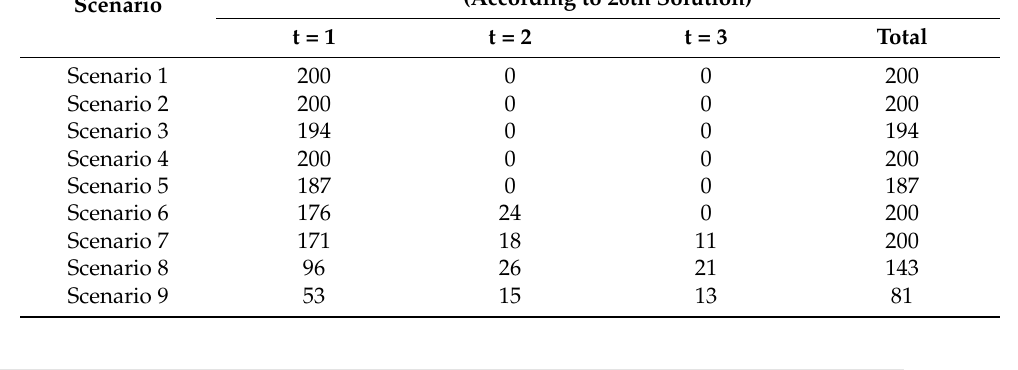
Table 5. The additional number of ambulances based on scenario and periods according to the 26th solution.